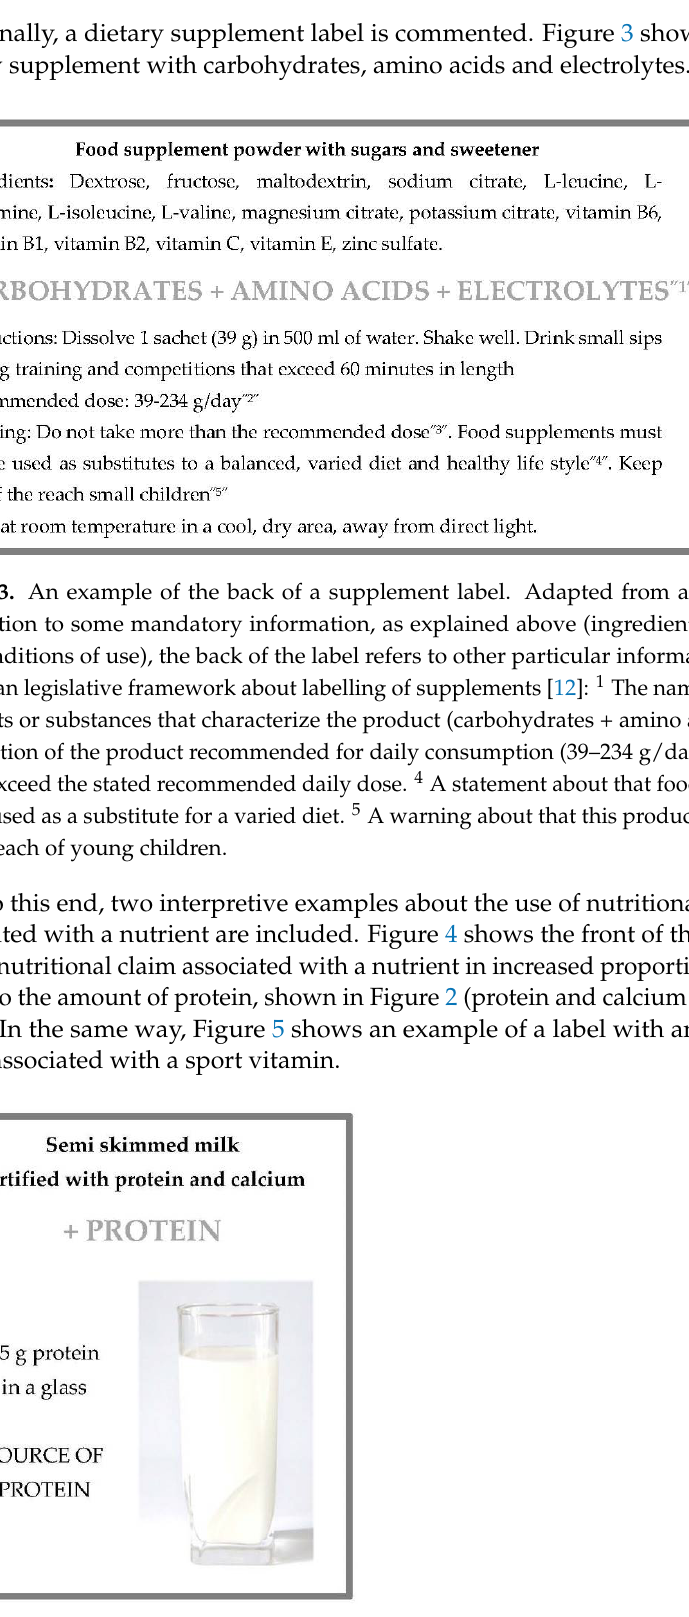
10 of 13 Figure 2. An example of the back of a fortified food label. Adapted from a commercial product. * nutrient reference values (NRVs). According to the European legislative framework, the mandatory nutrition declara- tions must be supplemented with an indication of the amounts of the added substances: